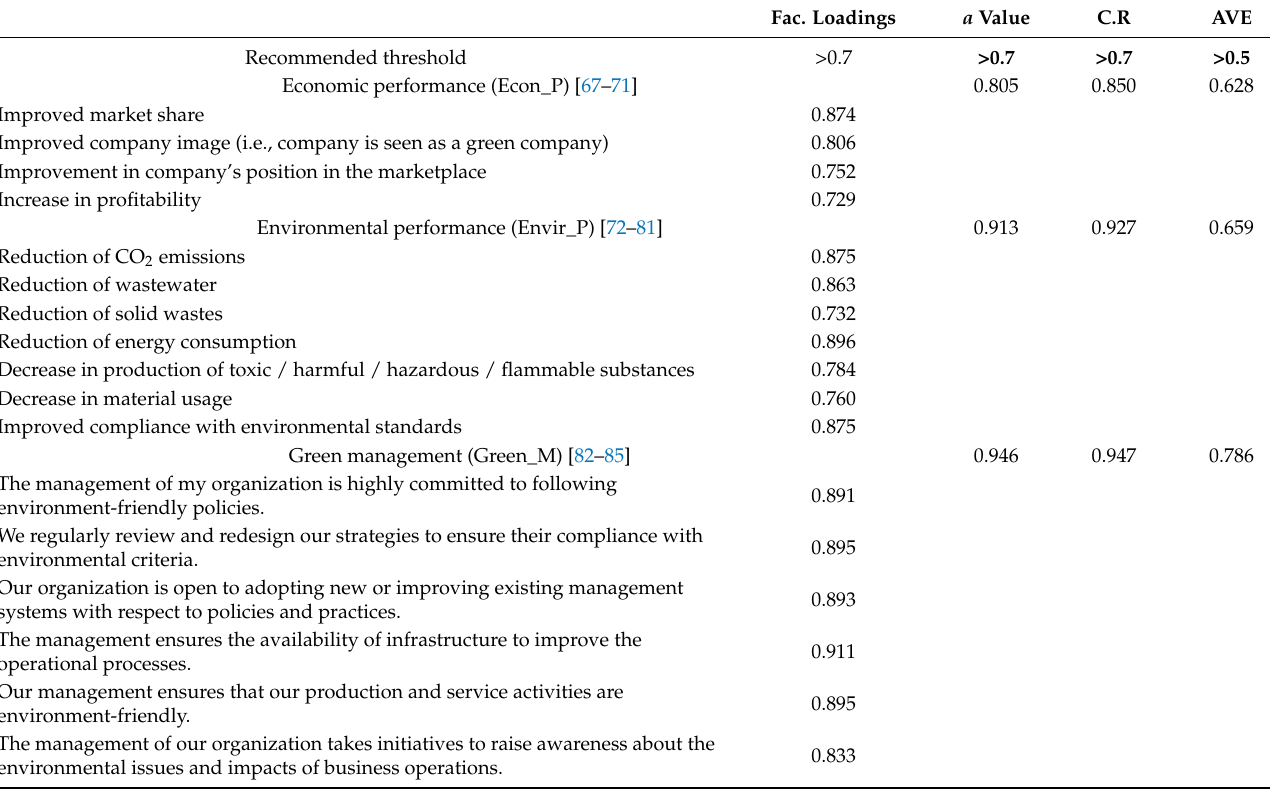
Table 1. Psychometric